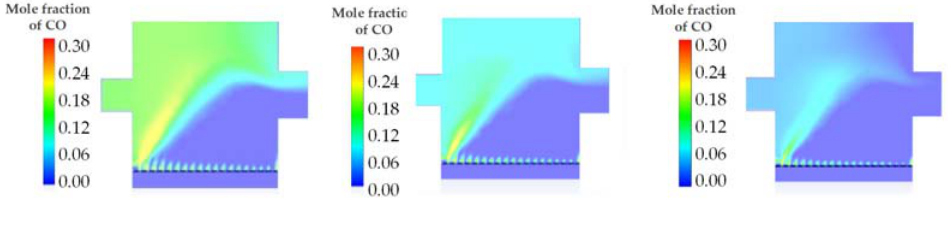
Figure 13. Contours of CO concentration.